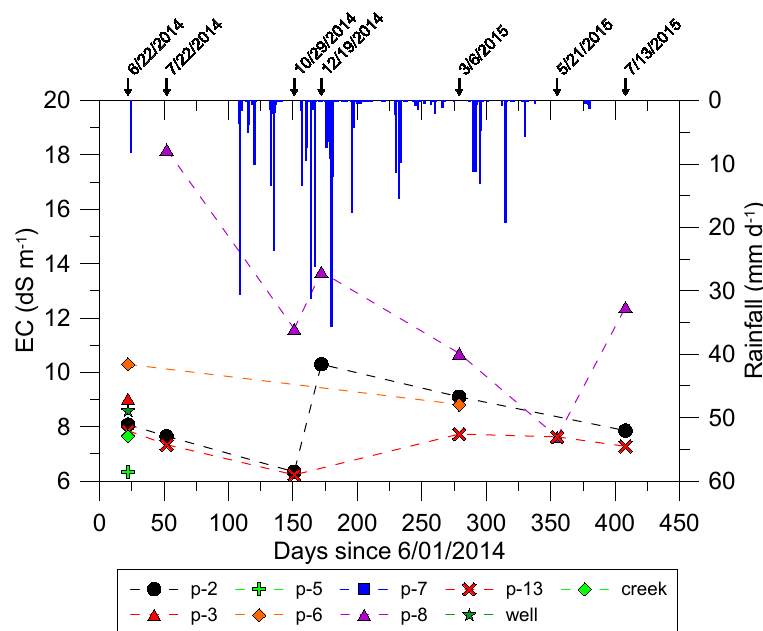
Figure 5. Daily rainfall and EC measured in the piezometers installed at the profile pits (indicated with prefix p in Figure 1), the well, and the creek in the northern part of the farm, from 22 June 2014 to 13 July 2015.